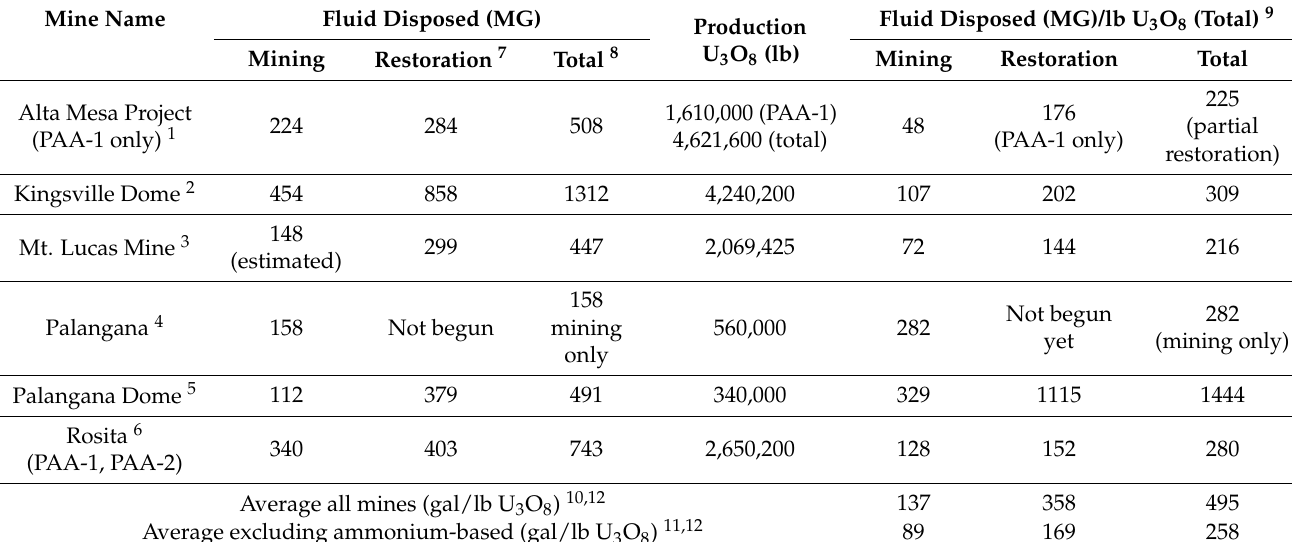
Table 1. Summary of minimum water disposed throughout the mine life, during production and during restoration normalized to U 3 O 8 produced.